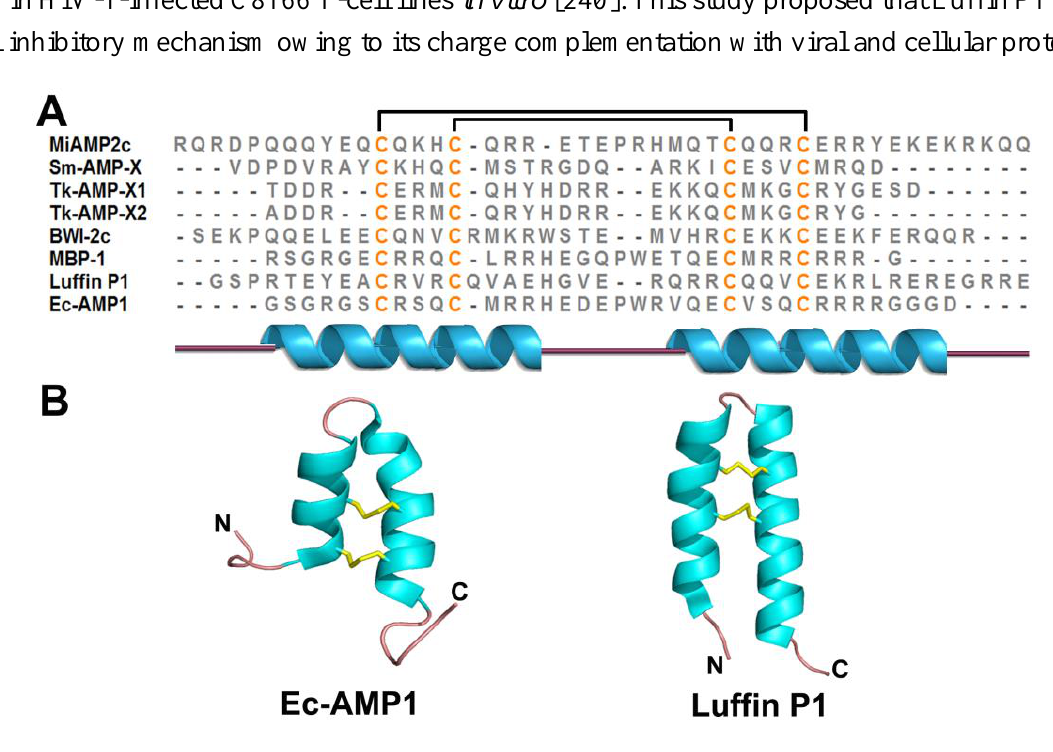
Figure 7. Sequences ( A ) and structures ( B ) of representative α-hairpinins. The secondary structure is represented by different colors: cyan-α helix; pink-random coil and yellow-disulfide